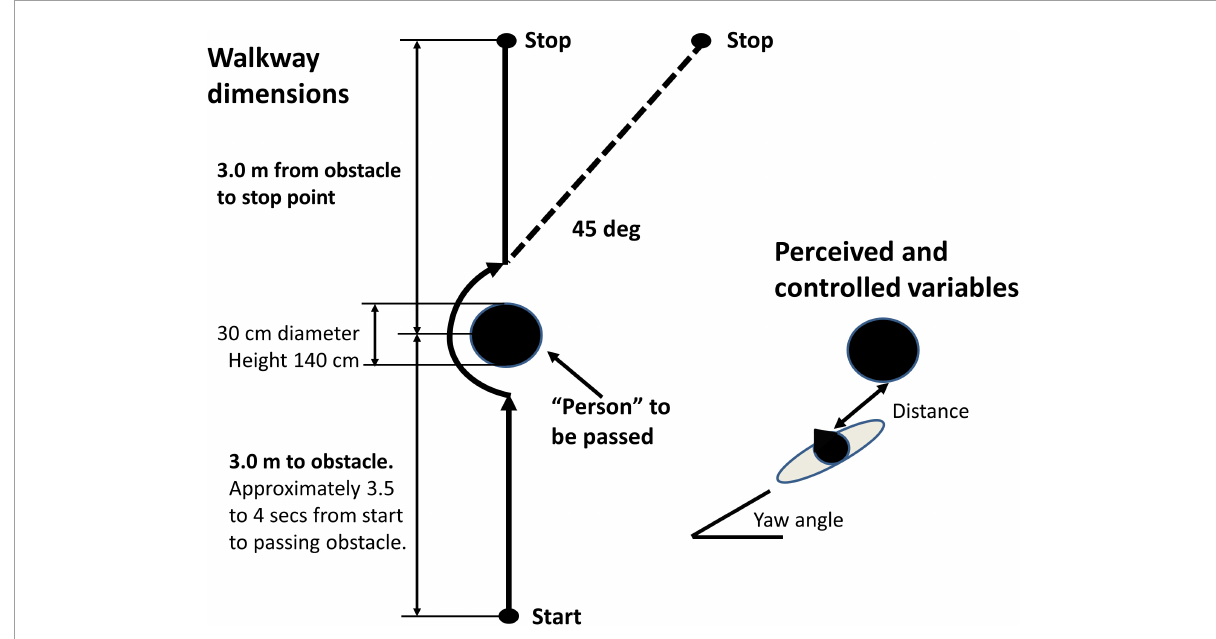
FIGURE2 Schema of experimental task. Left walkway dimensions. Right perceived and controlled variables to avoid a collision distance and trunk yaw angle. The subject was requested to walk 3 m toward a cylindrical obstacle, to pass it on the left or right as closely as possible as instructed immediately before the trial, then continue straight, or veer to the right 45 deg, if the obstacle was passed to the left (veering left if the obstacle was passed to right), before stopping 3 m past the obstacle in front of a